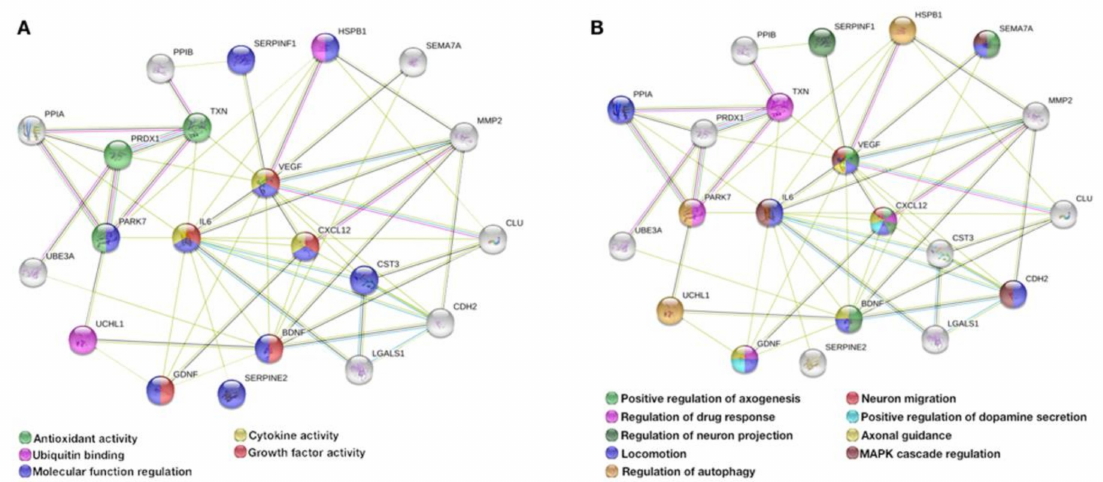
Figure 5. hBM-MSCs are producers of neuroregulatory molecules impacting PD. From previously generated proteomic databases derived from Bioplex-Luminex and Mass Spectrometry-based analysis, we were able to identify the presence of several (neuro)trophic factors and cytokines with important roles and therapeutic actions on PD. Of note, by STRING (Search Tool for the Retrieval of Interacting Genes / Proteins) bioinformatics research tool analysis, from those databases we identified a cluster of 21 interconnected proteins, namely Trx1 (TXN), SEMA7A, UCHL1, PEDF (SERPINF1), BDNF, Clusterin (CLU), SDF-1 (CXCL12), CypA (PPIA), CypB (PPIB), Cys C (CST3), VEGF, DJ-1 (PARK7), Gal-1 (LGALS1), GDNF, CDH2, IL-6, HSP27 (HSPB1), PRDX1, UBE3A, MMP-2, and GDN (SERPINE2), which from the ( A ) biological processes and ( B ) molecular function analysis revealed important actions to PD modeling and